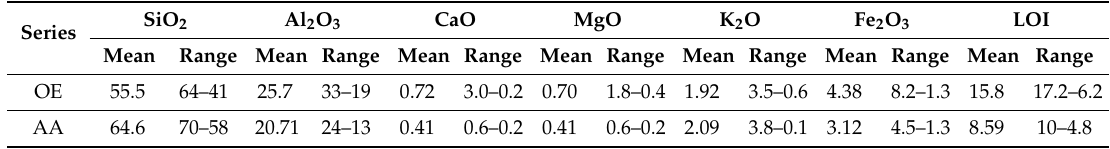
Table 3. Main elements (wt%). LOI: Loss on ignition.